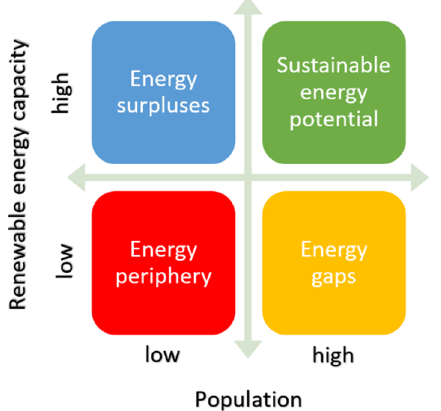
Figure 4. Outlined region types according to the energy/population parameters. Source: own